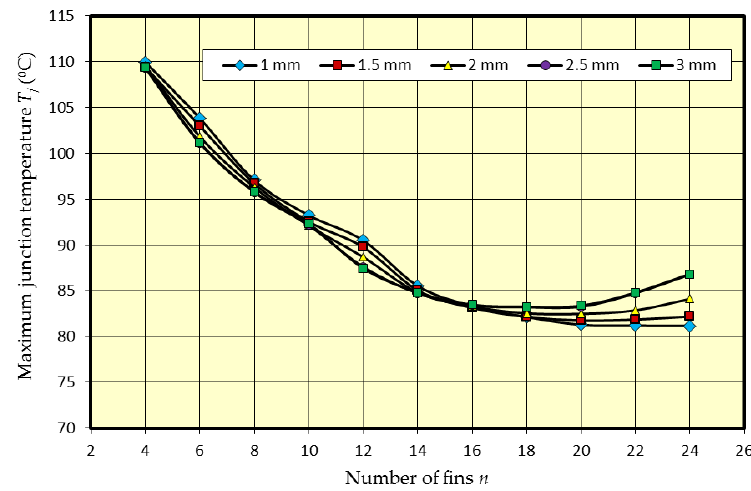
Figure 11. Maximum junction temperature T j of the LED panel sources in the function of radiator fins.